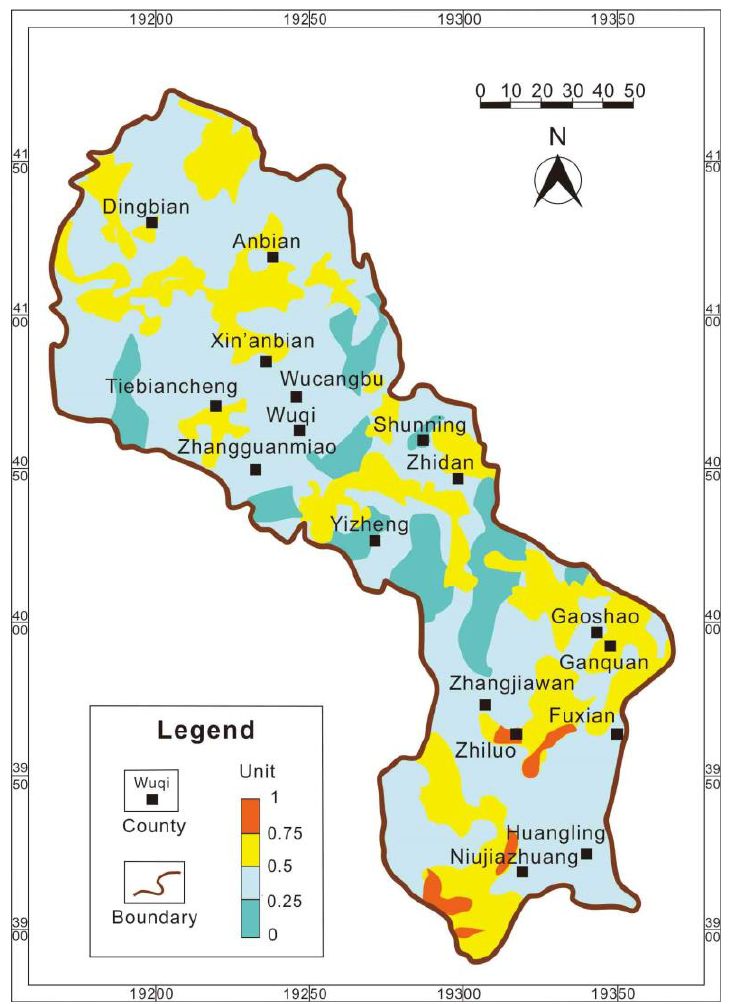
Figure 8. Bedding fractures distribution of tight sandstone reservoirs of Yanchang Formation in Ordos Basin during the Himalayan episode.